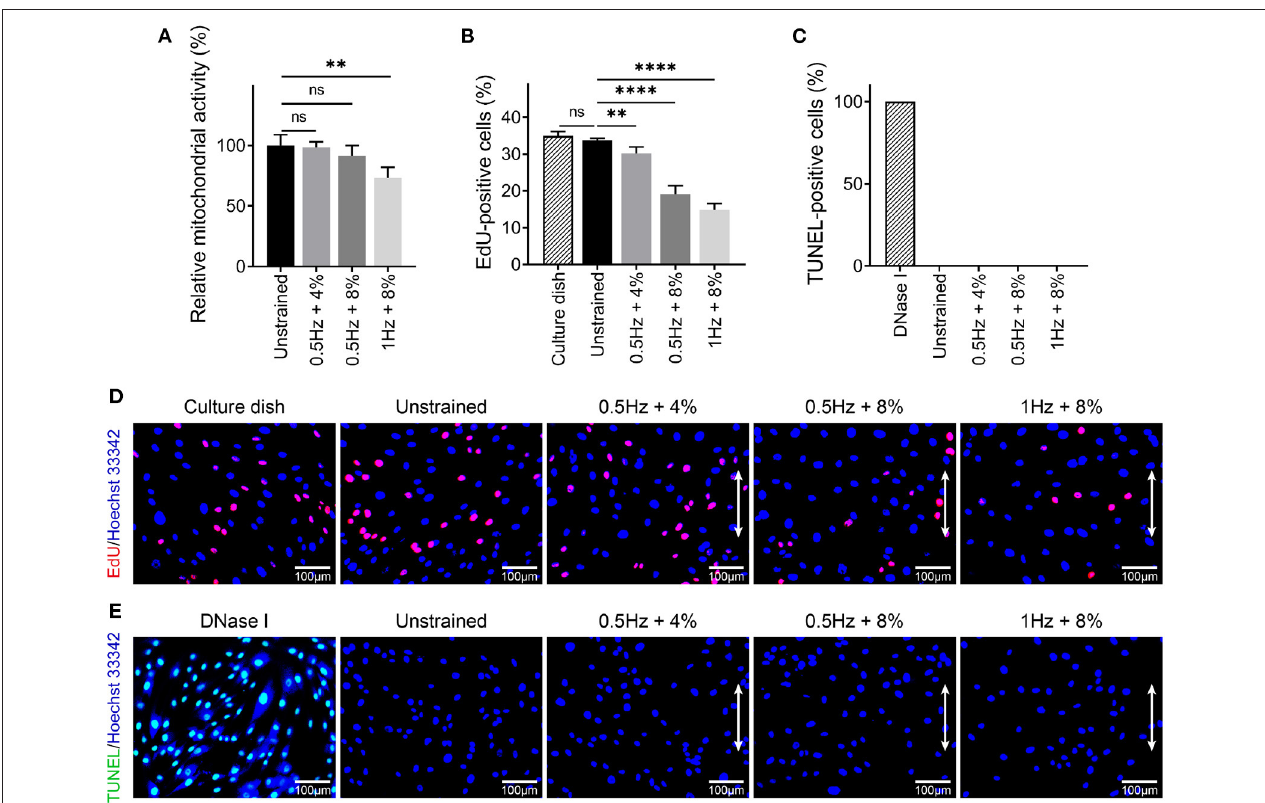
FIGURE 3 | (A) Analysis of relative mitochondrial activity of hMSCs in different mechanical conditions. Statistical significance was noted by ** P < 0.01. ns signifies P > 0.05. n = 4. (B,D) Quantitative analysis and representative fluorescence images of EdU-positive cells in culture dish and different cyclic stretch. Proliferating cells were labeled with EdU (red) and nuclei were stained with Hoechst 3,3342 (blue). White double-headed arrows indicate the direction of stretching. Statistical significance was noted by ** P < 0.01 and **** P < 0.0001. ns signifies P > 0.05. n = 4. (C,E) Quantitative analysis and representative fluorescent images of TUNEL-positive cells under DNase I treatment and different cyclic stretch. Apoptotic cells were labeled with TUNEL (green) and nuclei were stained with Hoechst 33342 (blue). White double-headed arrows indicate the direction of stretching. n =